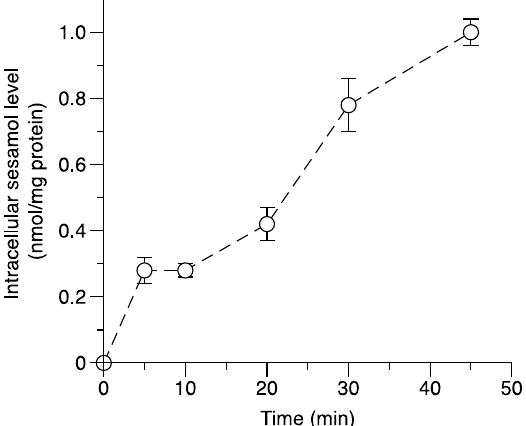
Figure 4. The time course relationship of the intracellular sesamol level (1 mM sesamol in SK-MEL-2 cells). The data were observed from 5 min to 45 min. The data are from three replicates.